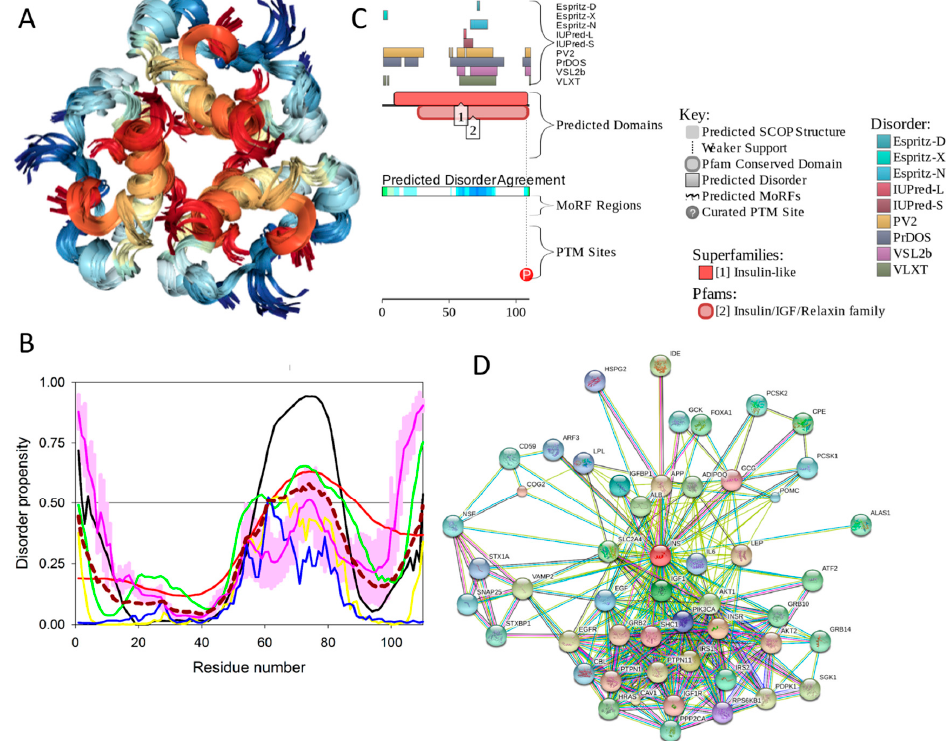
Figure 17. Structure and intrinsic disorder of human insulin (UniProt ID: P01308). ( A ) NMR solution structure of the insulin hexamer (PDB ID: 1AIY). This structure was generated by the NGL Viewer [201]. ( B ) Evaluating intrinsic disorder propensity of human insulin by series of per-residue disorder predictors. Disorder profiles generated by PONDR ® VLXT, PONDR ® VSL2, PONDR ® VL3, IUPred_short, IUPred_long, and PONDR ® FIT. ( C ) Analysis of the intrinsic disorder propensity and some important disorder-related functional information generated for human insulin by the D 2 P 2 database (available online: http://d2p2.pro/). ( D ) STRING-based analysis of the interactivity of